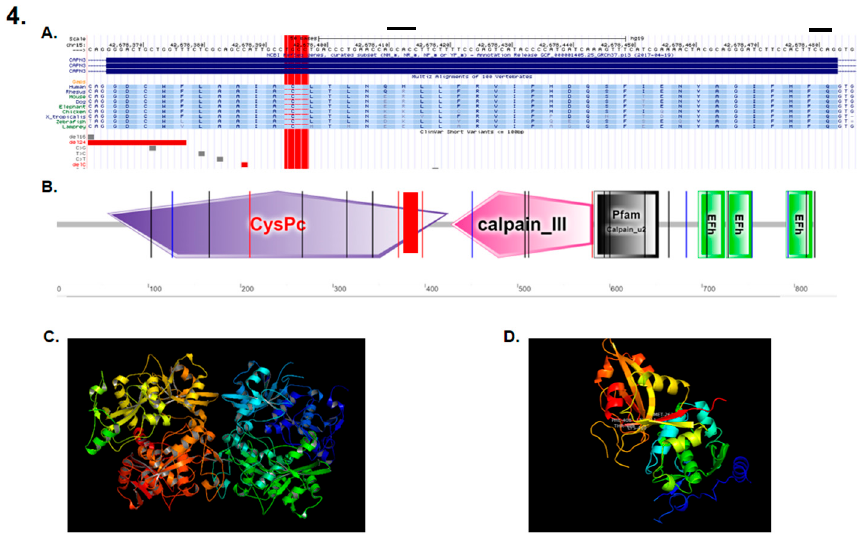
Figure 4. ( A ) Localization of the mutation consisting of a DNA deletion of four bases (TGCC) in exon 3 of the CAPN3 gene (409–412 del TGCC) (red rectangle). ( B ) The mutation is located within the calpain-like thiol protease family (peptidase family C2) region, with the large subunit corresponding to a calcium activated neutral protease. ( C ) Main calpain 3 protein. ( D ) Domain I of the calpain 3 protein when the described mutation is present.